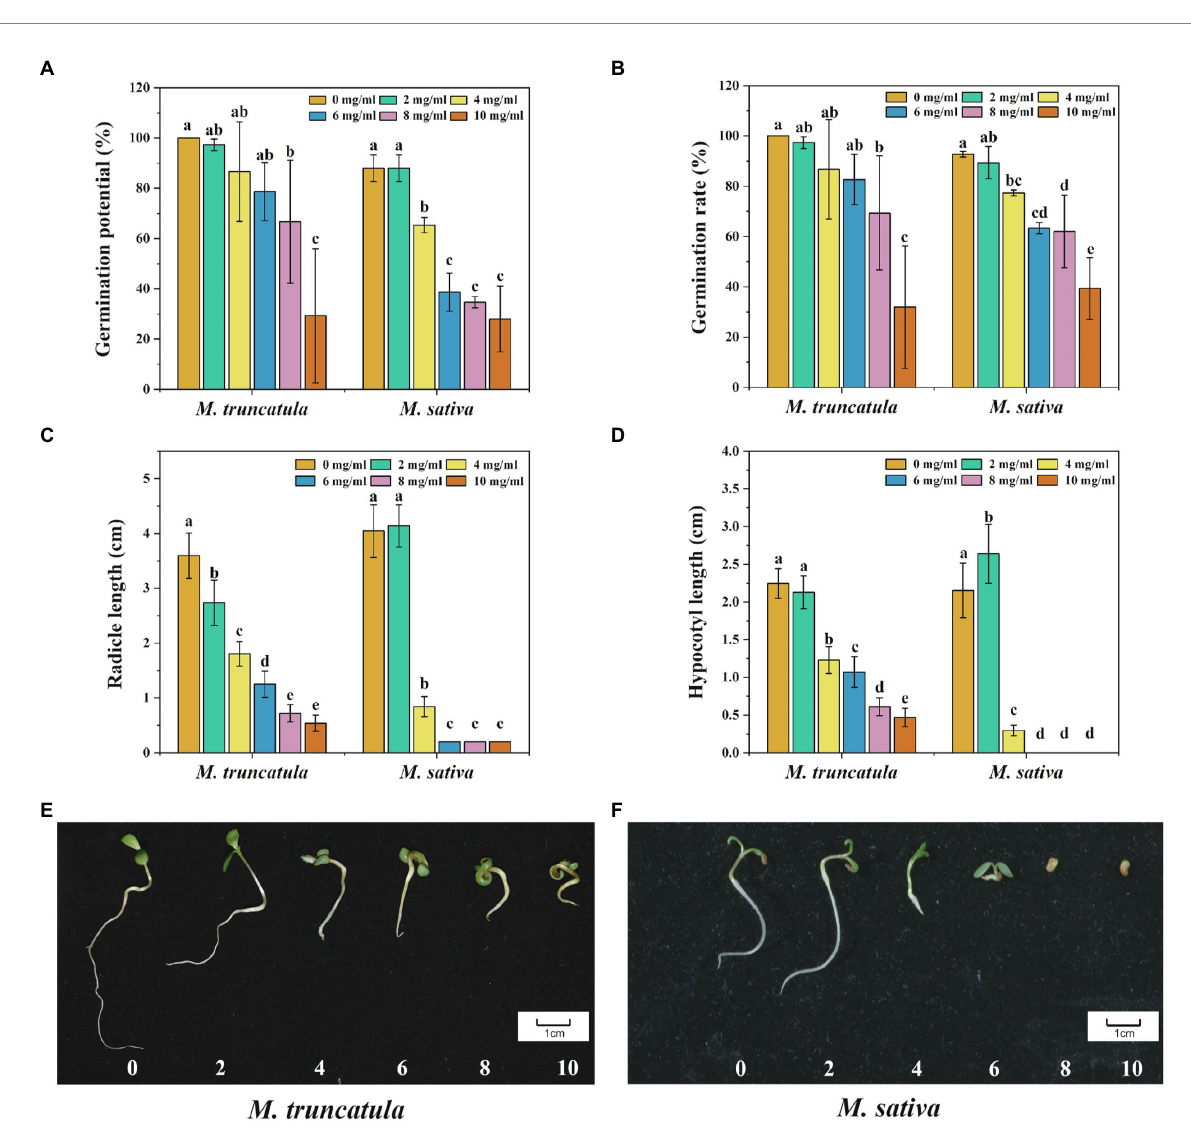
FIGURE 3 Effects of alfalfa extracts on seed germination and seedling growth of M. truncatula and alfalfa. (A) Germination potential; (B) germination rate; (C) radicle length; (D) hypocotyl length; (E) M. truncatula seedling growth; and (F) alfalfa seedling growth. Values represent means±SD of three biological replicates. Different letters above the bars indicate a significant difference ( p <